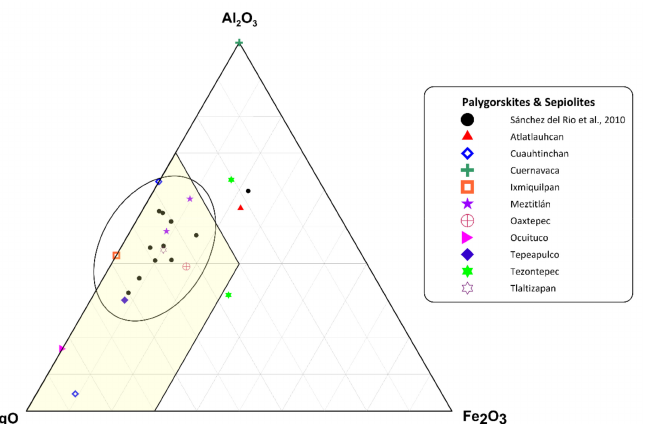
Figure 5. Triangular AFM diagram. In yellow, area determined for palygorskite and sepiolite samples studied by Garc í a-Romero & Su á rez